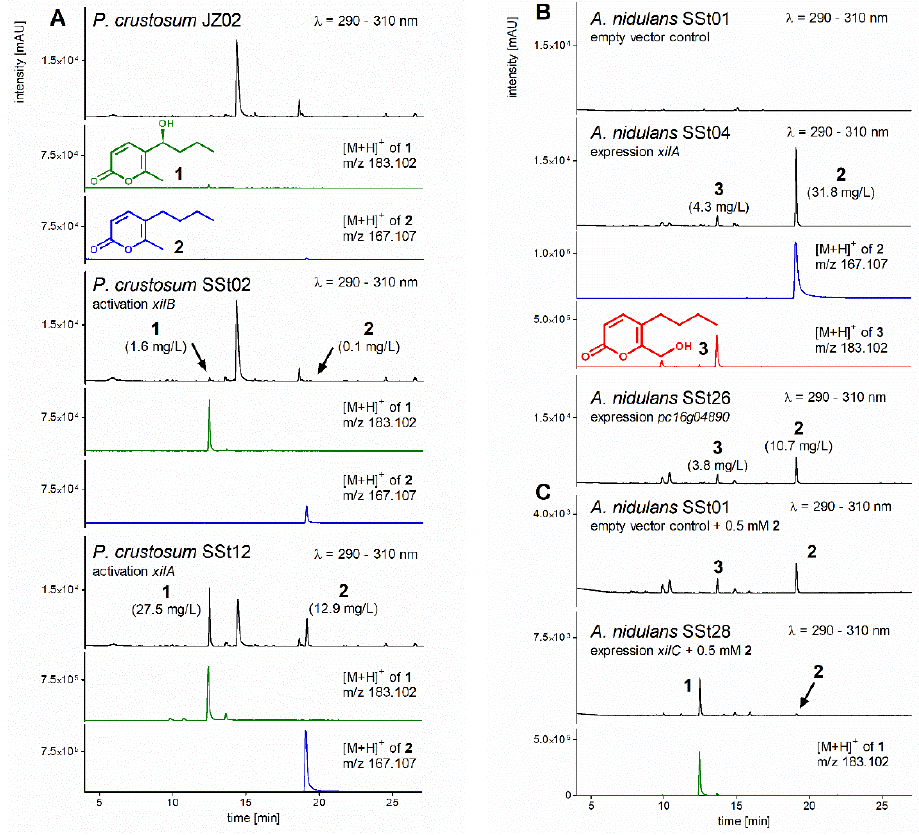
Figure 2. LC-MS analysis of fungal extracts. ( A ) Activation of the transcription factor xilB and polyketide synthase xilA in P. crustosum , ( B ) expression of xilA and its ortholog pc16g04890 in A. nidulans , ( C ) adding 2 to A. nidulans with and without xilC expression. Compounds 1 – 3 with their EICs are highlighted in green, blue, and red, respectively. A tolerance range of ± 0.005 was used for ion detection. Product yields after gene activation or expression are given in parentheses under the compound numbers.